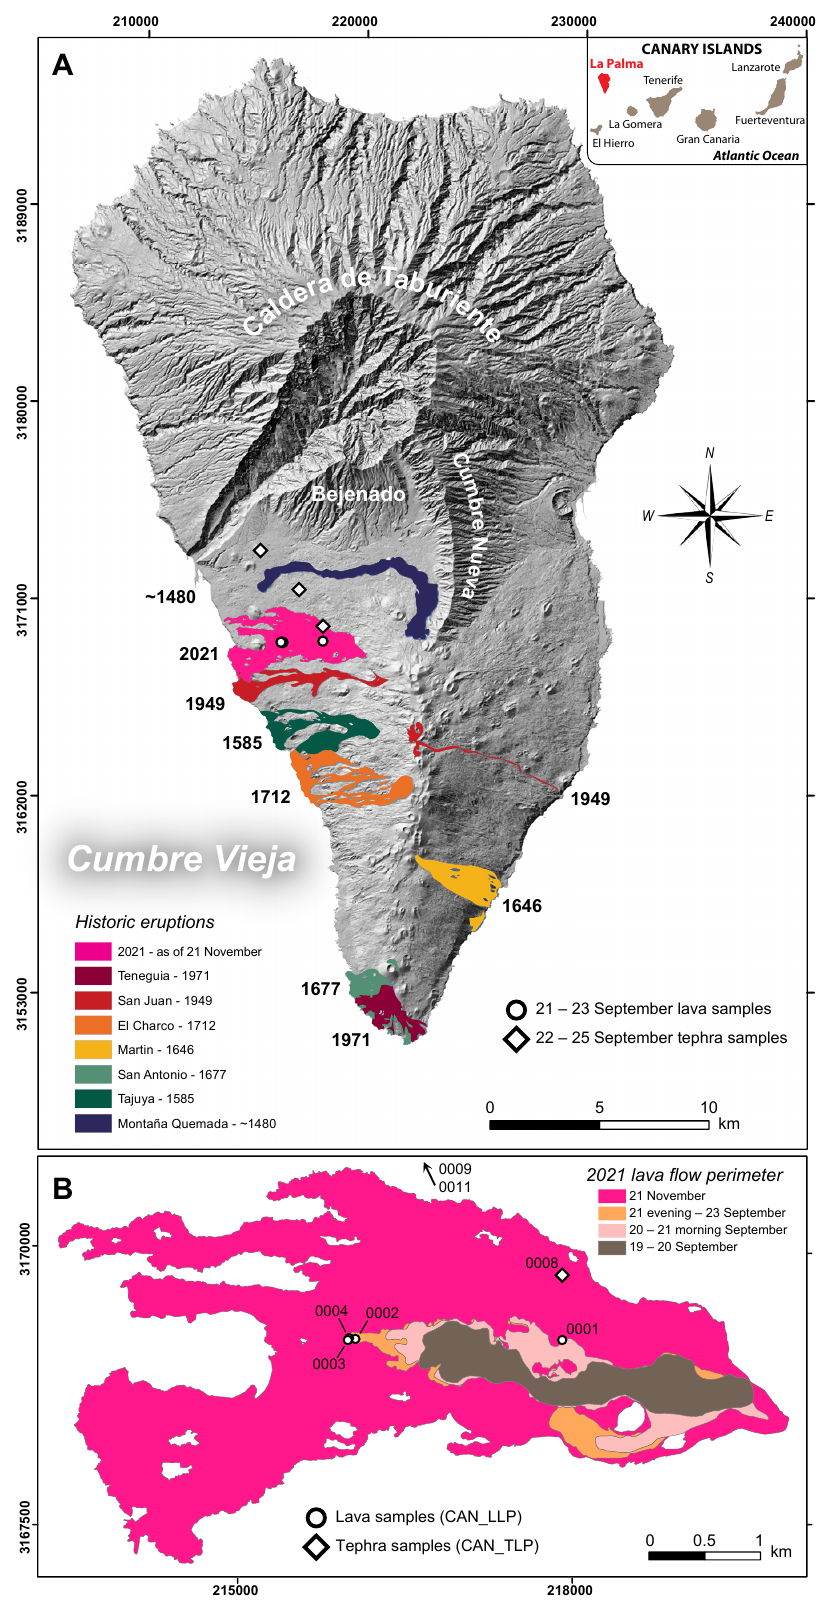
Figure 1. Pankhurst et al. Figure 1: [A] Locations of lava and tephra samples and historic eruptions [Hernandez-Pacheco and Valls 1982; (Two columns; 108 mm width x 220 mm height) Romero Ruiz 1990; Global Volcanism Program 2013]; [B] selected flow extent snapshots and sample